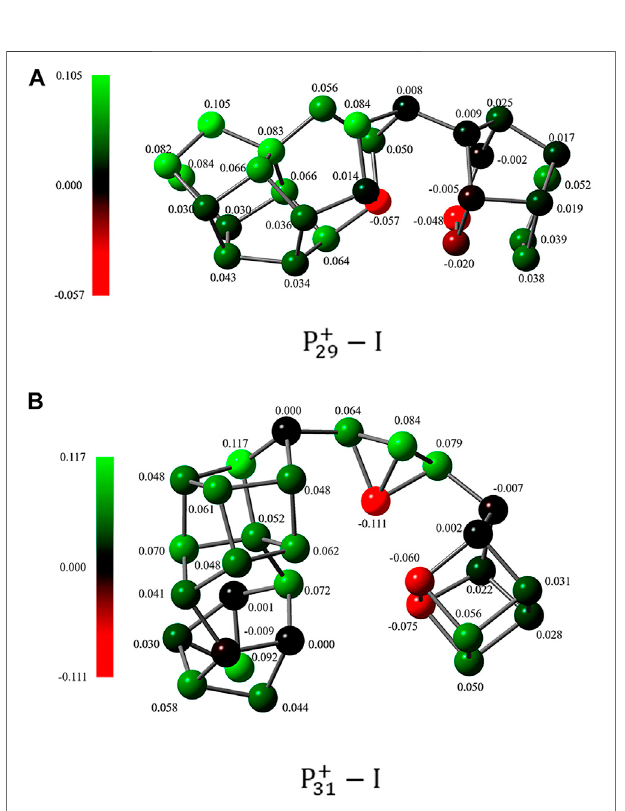
FIGURE 6 | The NBO charge distribution of (A) P + 29 − I and (B) P + 31 − I.